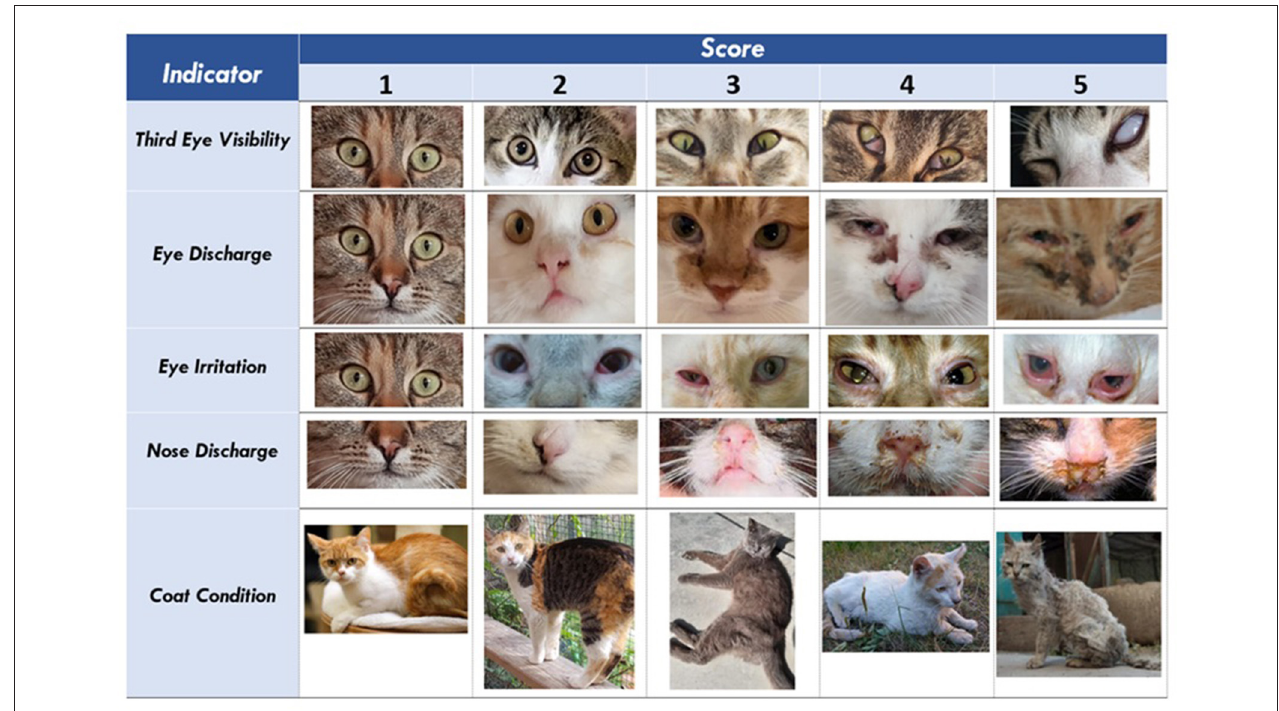
FIGURE 1 | Calibration photo sheet—assessment of